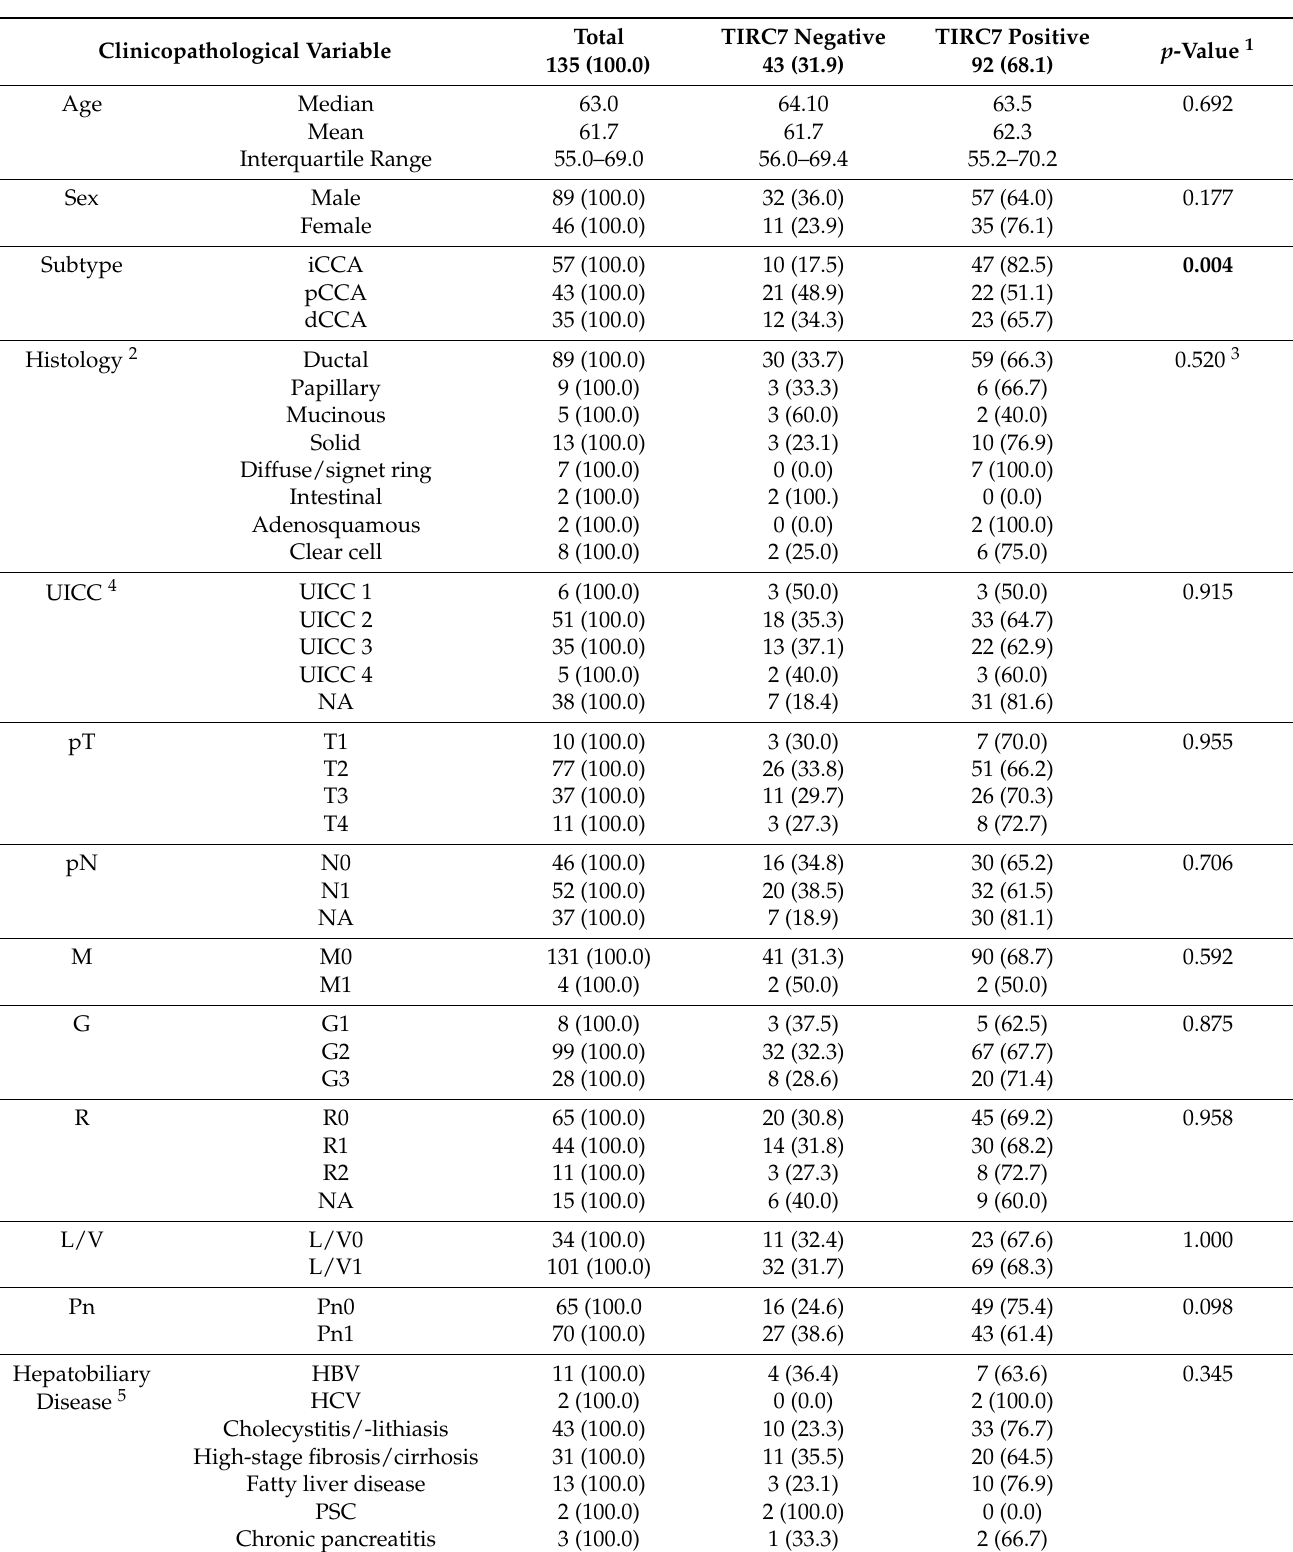
Table 1. Clinicopathological characteristics stratified for intraepithelial